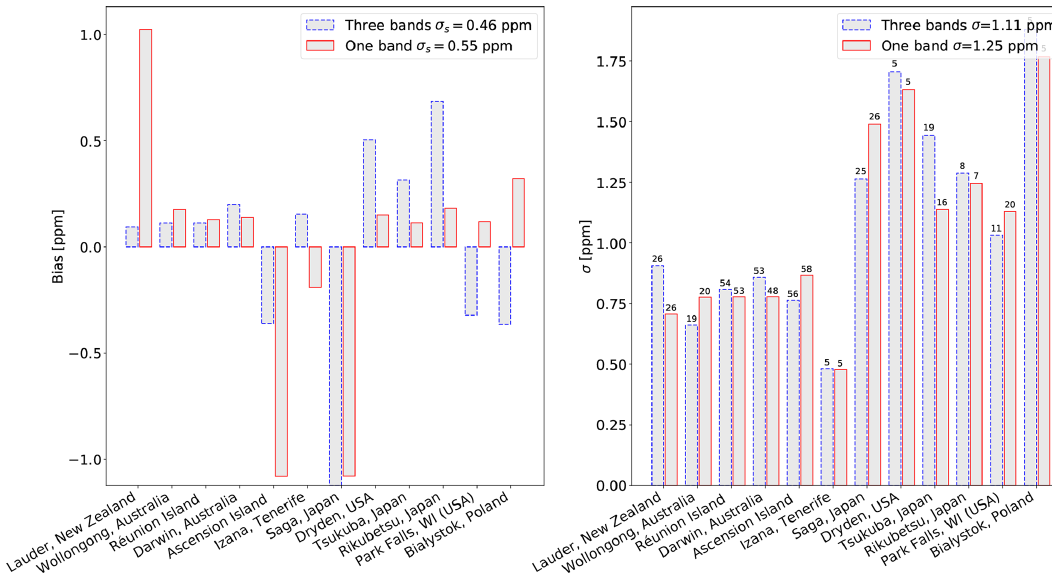
Figure 3. Same as Fig. 2, but for retrievals over ocean.